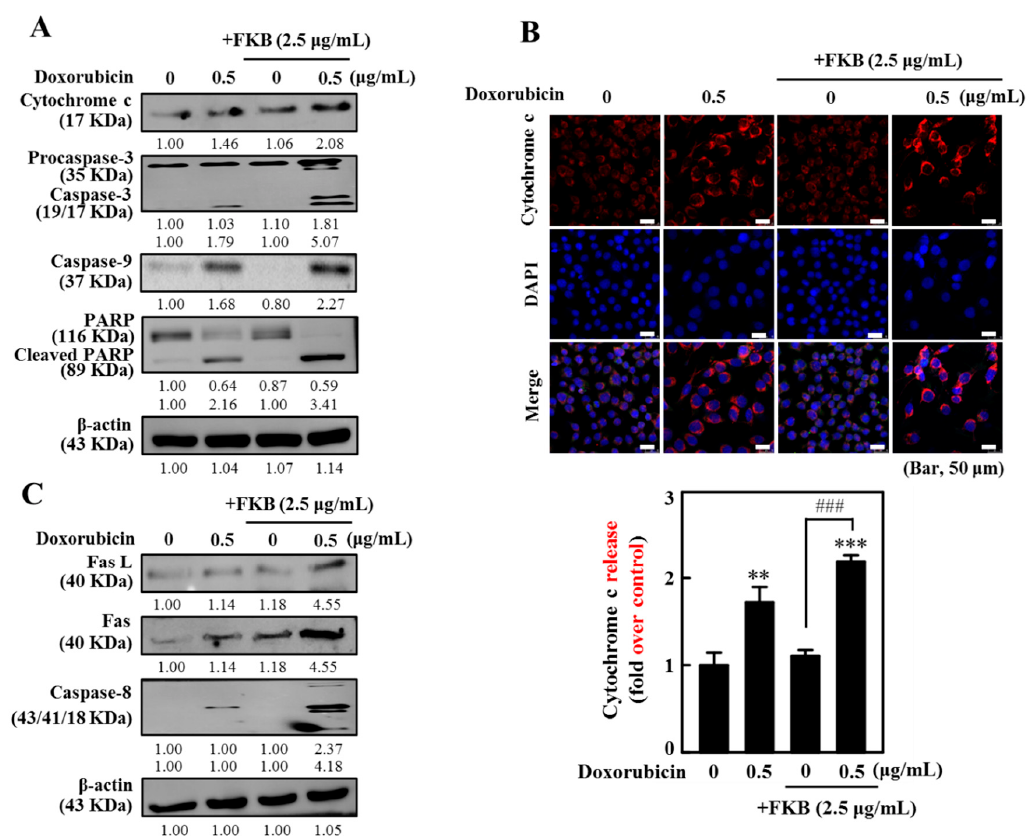
Figure 2. Induced apoptosis in AGS cells via the mitochondrial and death receptor pathways. The cells have been exposed to FKB (2.5 µg/mL), doxorubicin (0.5 µg/mL), and their 24-h combination. ( A ) Western blot analysis of the cytochrome levels c, caspase-3, caspase-9, and PARP (Figure S2). ( B ) Immunofluorescence staining indicates changes in expression of the cytochrome c. ( C ) Western